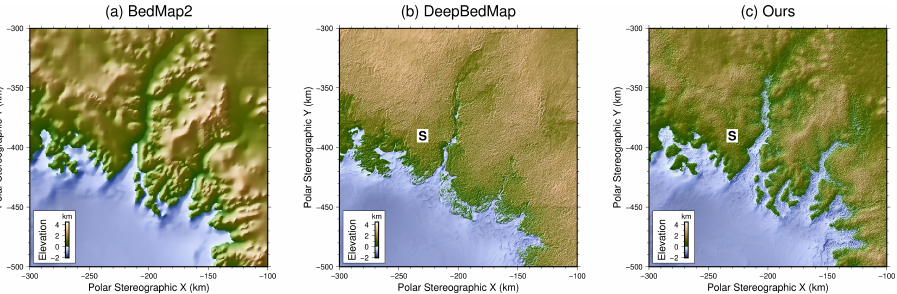
Figure 7. Bed topography comparison over steep mountains area. Features of interest are annotated in black text against a white background: speckle patterns S